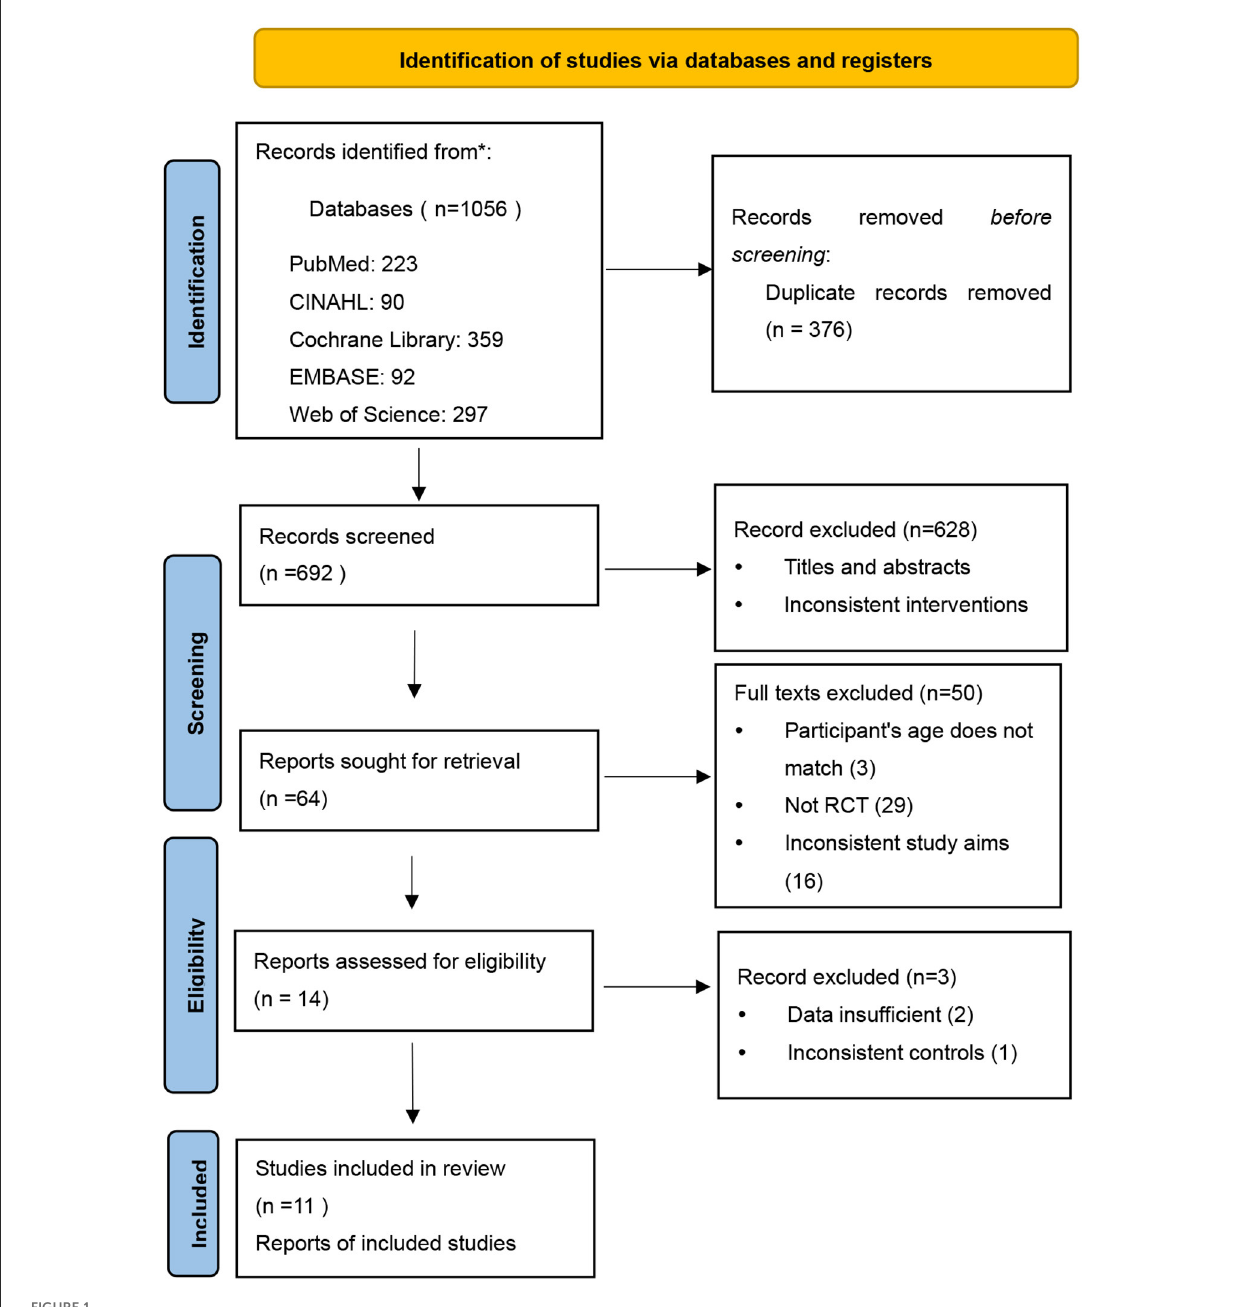
FIGURE1 A flow diagram of the studies included in the